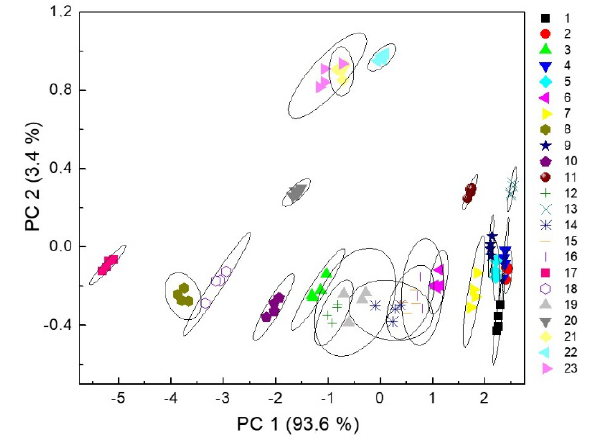
Figure 6. The scores plots of the emission spectra of honeys with added thiazole orange intercalated into DNA-2 in a ratio of 1:53 (TO–DNA-2).